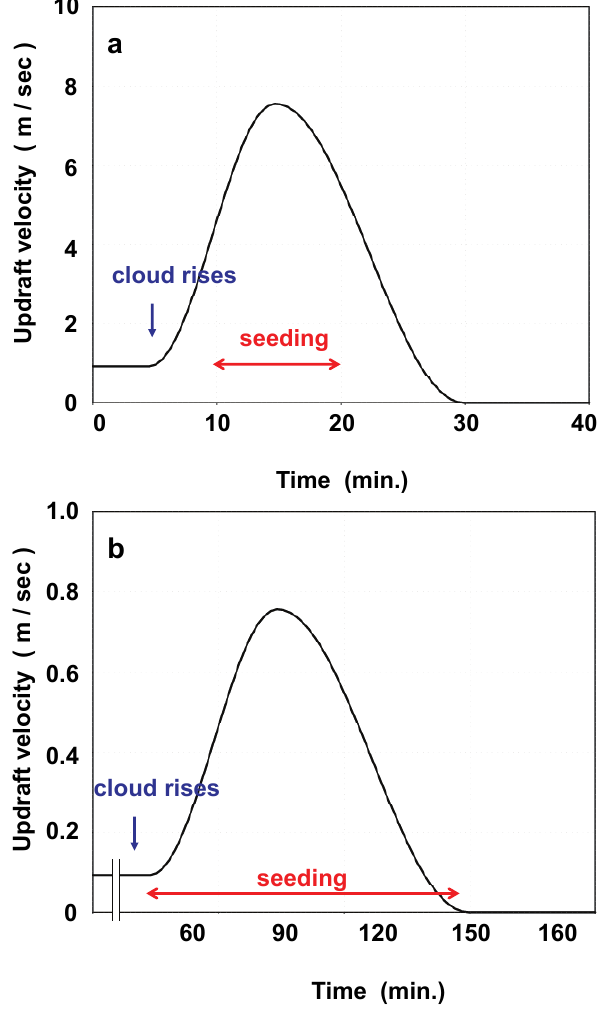
Fig. 2. Time evolution of updraft velocity near the center of the cloud for the shallow convective cloud case (a) and for the strati- form cloud case (b)